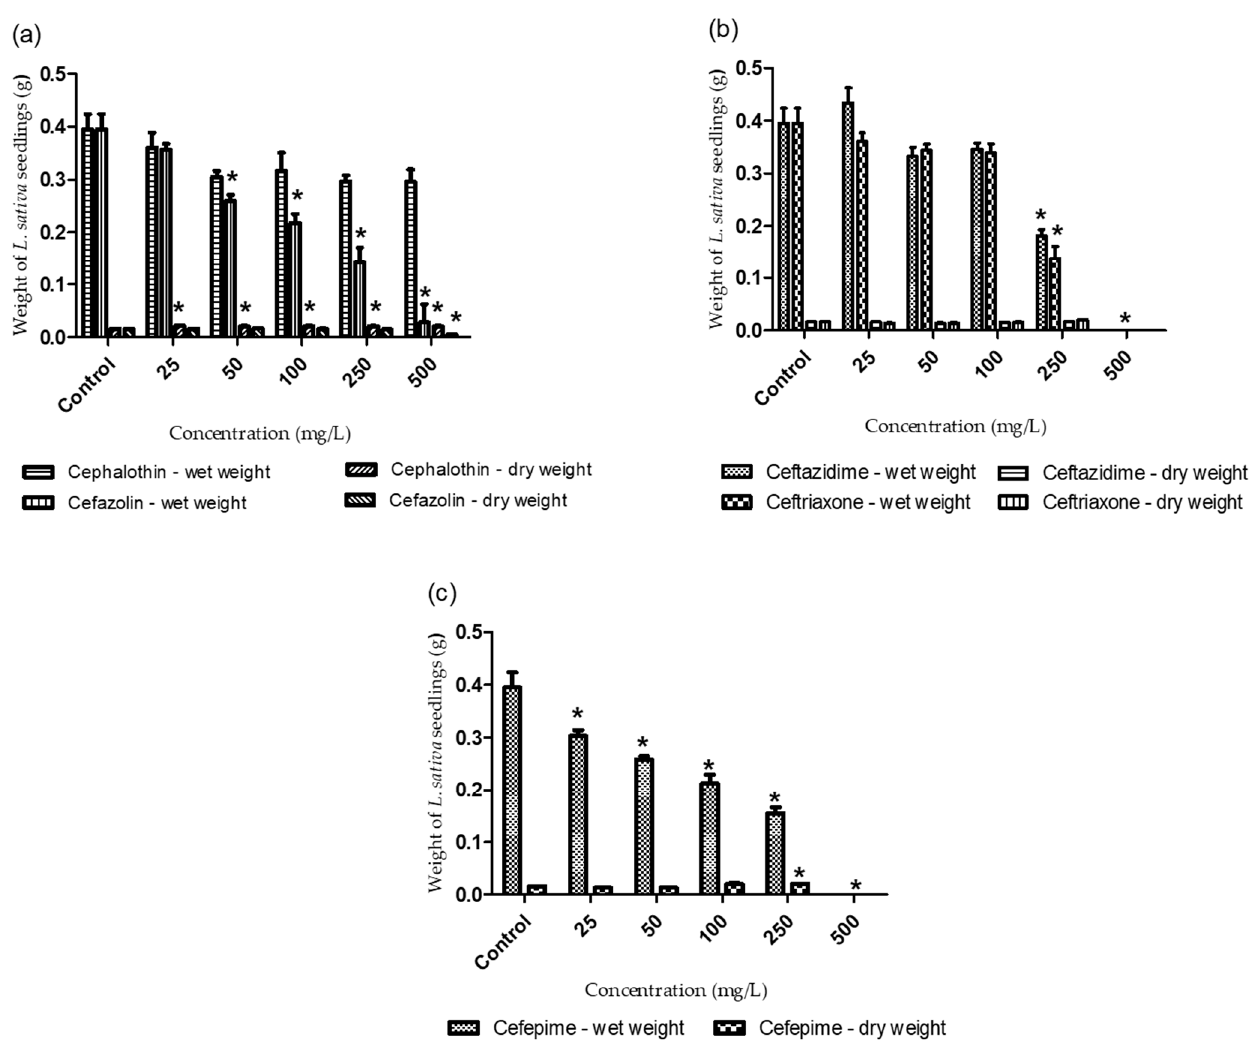
Figure 3. Wet and dry weight of L. sativa seedlings exposed to different cephalosporins. ( a ) wet and dry weight in cephalosporins of the first generation, ( b ) wet and dry weight in cephalosporins of the third, and ( c ) wet and dry weight fourth generation. * indicates significance at the p < 0.05 level compared to the control.